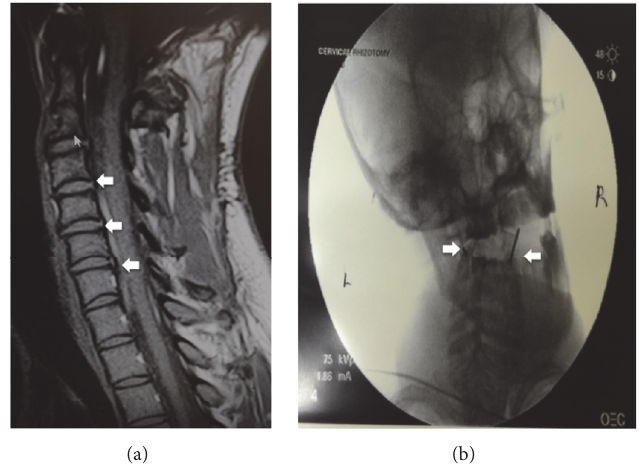
Figure 1: (a) MRI of the cervical spine showed degenerative changes observed at C2 (thin arrow). Multilevel disc desiccation at C2–C5 without disc height loss; C2-C3 and C3-C4 disc bulge with uncovertebral joint hypertrophy and spinal canal stenosis (fat arrows) were noted. (b) Open-mouth view of atlantoaxial joint confirmed bilateral intra-articular RFN needle placement (arrows) into the AA joint.